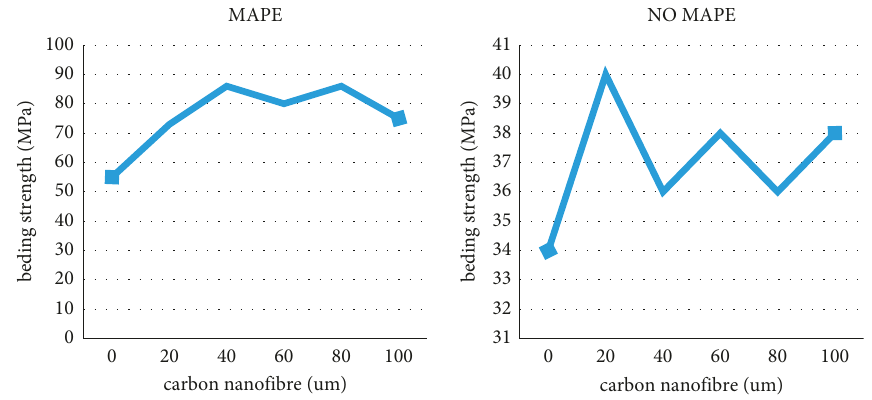
Figure 7: Comparison of bending properties of composites.